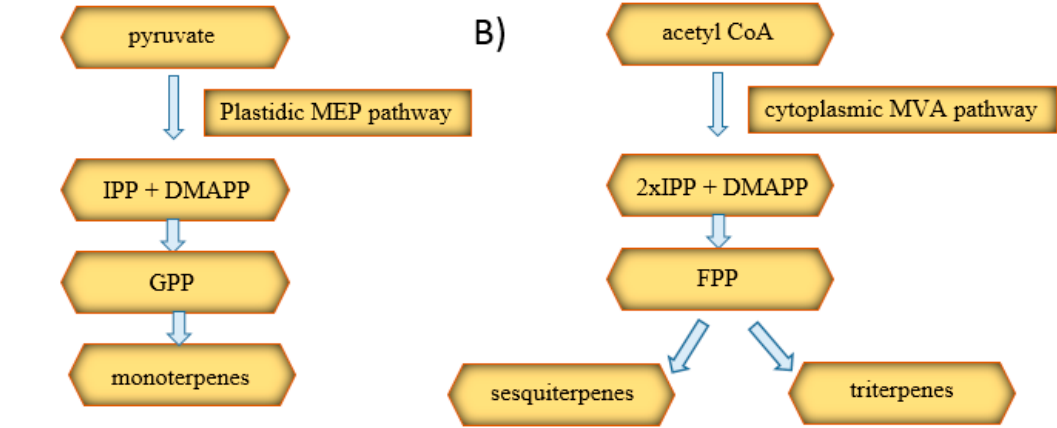
Figure 6. Diagram of the biosynthesis of monoterpenes ( A ), sesquiterpenes, and triterpenes ( B ) [42]. MEP: methylerythritol phosphate, IPP: isopentenyl diphosphate, DMAPP: dimethylallyl diphosphate, GPP: geranyl diphosphate, MVA: mevalonic acid, and FPP: farnesyl diphosphate.